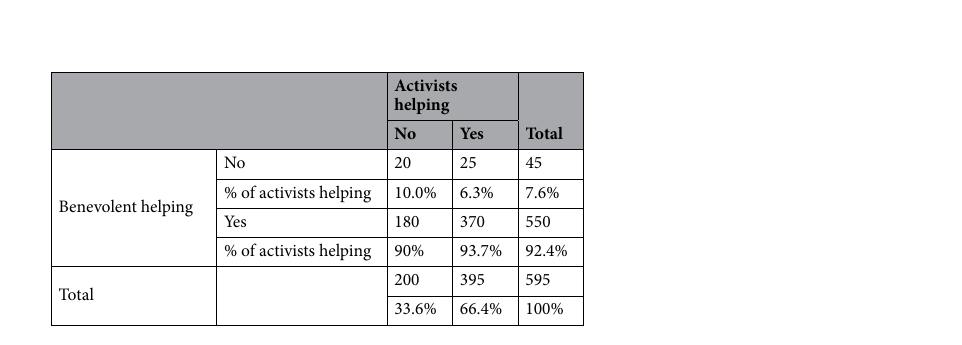
Table 1. The results of the four models testing psychological predictors of helping. OR odds ratio.